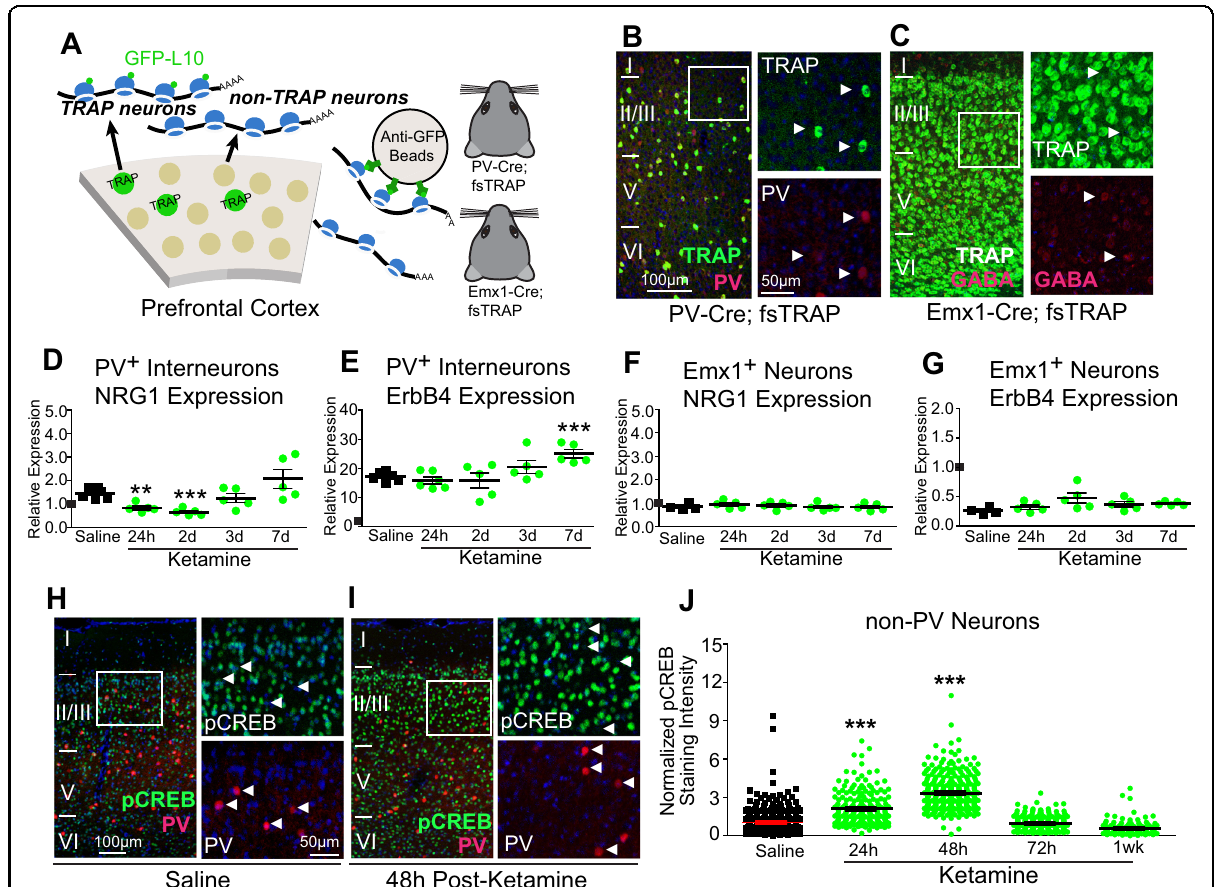
Fig. 4 NRG1 expression in PV neurons is reduced by ketamine. A – G Testing the effect of ketamine on NRG1 mRNA expression using TRAP. A A schematic illustration of the translating ribosome af fi nity puri fi cation strategy 37 . Using PV-Cre; fsTRAP mice, translating ribosomes (polysomes) from PV cells (green cells) have EGFP tags from the EGFP-L10 transgene. Lysis of all cells in the PV-Cre; fsTRAP cortex releases both tagged and non-tagged polysomes. The tagged polysomes are selectively captured on an anti-GFP af fi nity matrix and used for puri fi cation of PV-speci fi c mRNAs associated with tagged polysomes. This strategy is also used to purify mRNA from Emx1 + neurons using Emx1-Cre; fsTRAP mice. Mice were treated with saline or ketamine at P56, then sacri fi ced 24, 48, 72h or 1 week later for fsTRAP extraction and qPCR analysis. See “ Methods ” for more information. B Confocal images of genetically labeled PV cells (green), PV immunolabeling (red) and their overlay in layer I-VI of mouse mPFC in P56 PV-Cre; fsTRAP-EGFP mice; Scale bar = 100µm. The white boxes indicate the region of mPFC imaged at higher magni fi cation ( B , right); Scale bar = 50µm. C Confocal images of genetically labeled excitatory cells (green), GABA immunolabeling (red) and their overlay in layer I-VI of mouse mPFC in P56 Emx1-Cre; fsTRAP-EGFP mice. The white boxes indicate the region of mPFC imaged at higher magni fi cation ( C , right). Arrowheads indicate GABA immunopositive cells. D – G All results were analyzed using the ddCt method with gapdh as an endogenous control, along with normalization to Emx1 + P56 nrg1 expression, as indicated by a black mark on the y -axis, so that all panels ( D – G) can be compared 71 . ( D ) Ketamine treatment (10mg/kg; s.c.) signi fi cantly lowers NRG1 mRNA expression levels from PV neurons (PV-Cre; fsTRAP) in mPFC in P56 mice ( n = 5 – 6 samples; each sample is pooled from 5 mice for PV cell-speci fi c data) (One-way ANOVA: overall p = 0.0006. Two-sample t test (adjusted for multiple comparisons): ketamine vs saline, 24h (1d) p = 0.0027, 48h (2d) p = 0.0002; mean±SEM). E PV cell-speci fi c mRNA expression levels of ErbB4 from mice treated with saline or ketamine (One-way ANOVA: overall p = 0.0018. Two-sample t test (adjusted for multiple comparisons): ketamine vs saline, 1 week p = 4.55×10 − 4 ); mean±SEM. F Emx1 + cell-speci fi c (Emx1-Cre; fsTRAP) NRG1 mRNA expression levels from mPFC cortices ( n = 4 – 5 samples; each sample is pooled from two mice for Emx1 + cell-speci fi c data) is not signi fi cantly changed with ketamine treatment (10mg/kg; s.c.). G Emx1 + cell-speci fi c ErbB4 mRNA expression levels are not signi fi cantly changed with ketamine treatment (10mg/ kg; s.c.), and are much lower than in PV cells. H – J Testing the effect of ketamine on pCREB expression in excitatory neurons. H Confocal images of genetically labeled PV cells (red), pCREB immunolabeling (green) and their overlay in layer I-VI of mouse mPFC in P56 PV-Cre; Ai9 mice treated with saline; Scale bar = 100µm. The white box indicates the region of mPFC digitally enlarged ( H , right); Scale bar = 50µm. White arrowheads indicate that PV neurons have very low pCREB immunoreactivity. I Confocal images of genetically labeled PV cells (red), pCREB immunolabeling (green) and their overlay in layer I-VI of mouse mPFC in P56 PV-Cre; Ai9 mice 48h after ketamine treatment (10mg/kg; s.c.). The white boxes indicate the region of mPFC digitally enlarged (I, right). White arrowheads indicate that PV neurons have very low pCREB immunoreactivity. J Quanti fi cation of the increase in pCREB immunoreactivity in mPFC 24 and 48h after ketamine treatment. After 72h to 1 week pCREB levels return to baseline (linear mixed effect model: overall p = 4.3×10 − 32 , ketamine vs saline, 24h p = 2.37×10 − 5 , 48h p = 1.51×10 − 23 ; mean±SEM). Please see the “ Methods ” section for quanti fi cation and normalization of immunostaining intensity; the overall normalized values from different mice were compared across treatment groups ( n = 6 for saline; n = 3 – 6 for ketamine